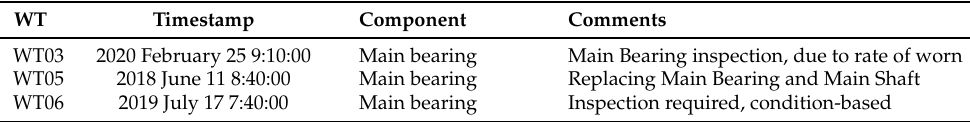
Table 5. Main bearing failures reported in the work order